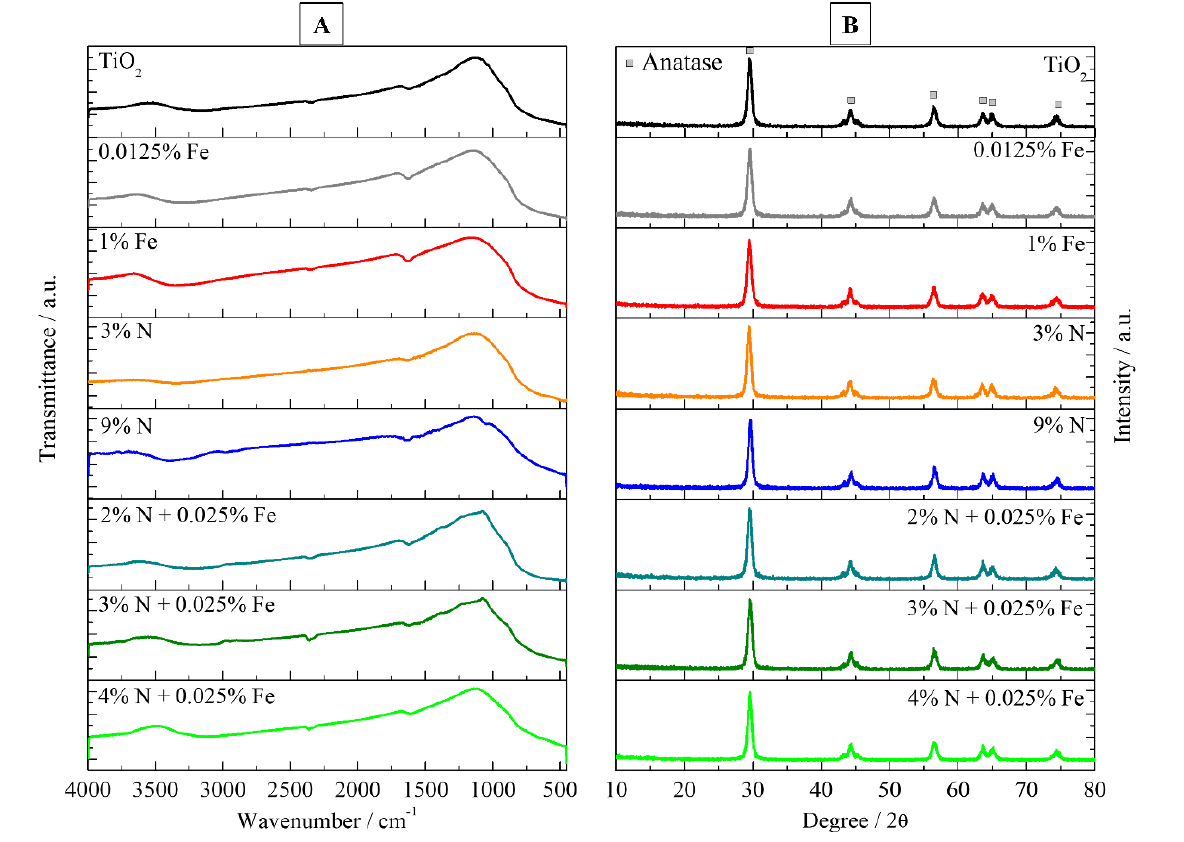
Figure 2. ( A ) FTIR spectra, and ( B ) X-ray diffraction patterns of N-, Fe-, and N-Fe doped TiO 2 pho- tocatalysts.